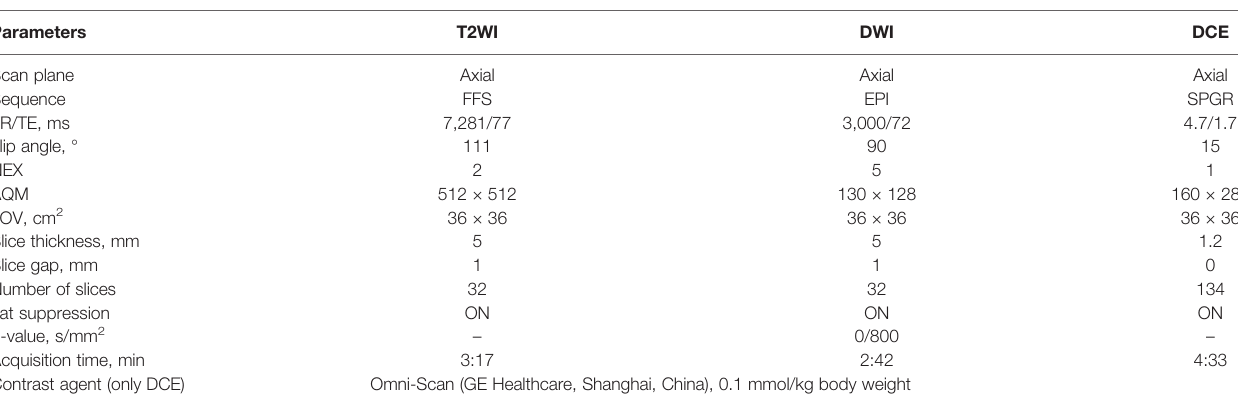
TABLE 1 | MRI protocol parameters. Parameters T2WI DWI DCE Scan